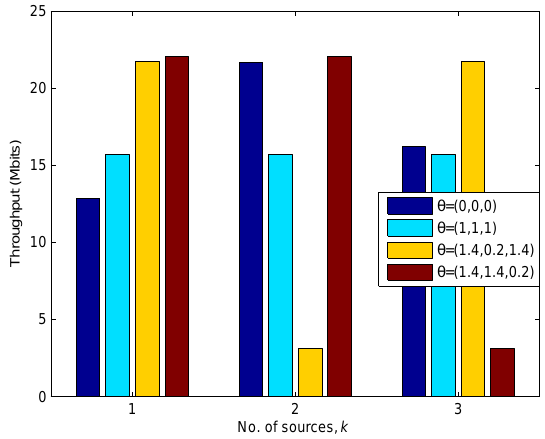
Figure 11. The Throughput of each source under different θ for T = 60 s.